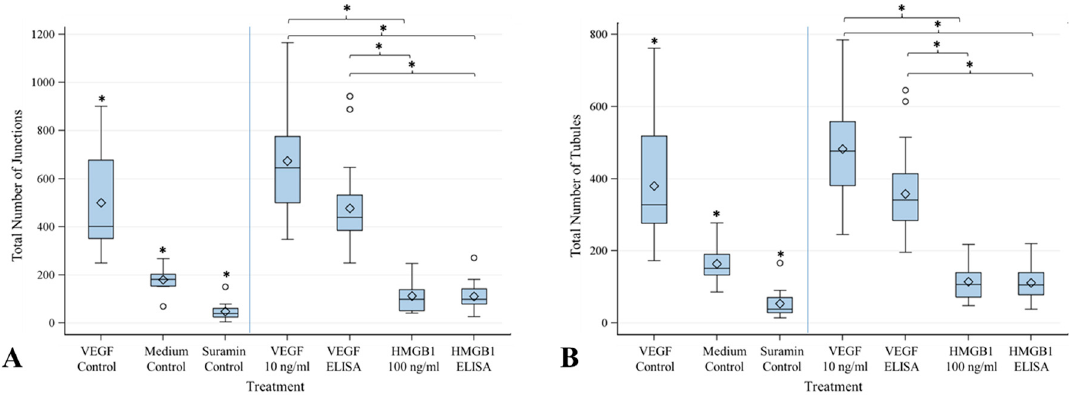
Figure 8. Cont. Figure 8. Cont.